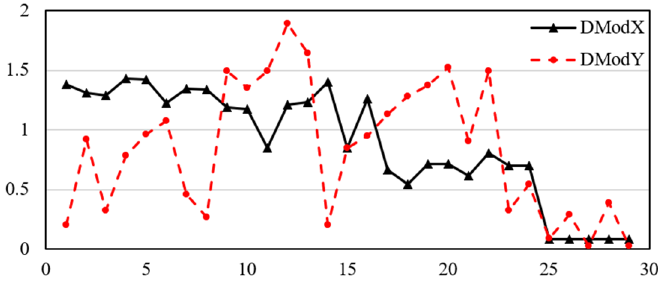
Figure 10. Construction quality of M 6400 . Table 9. Prediction error of M 6400 .